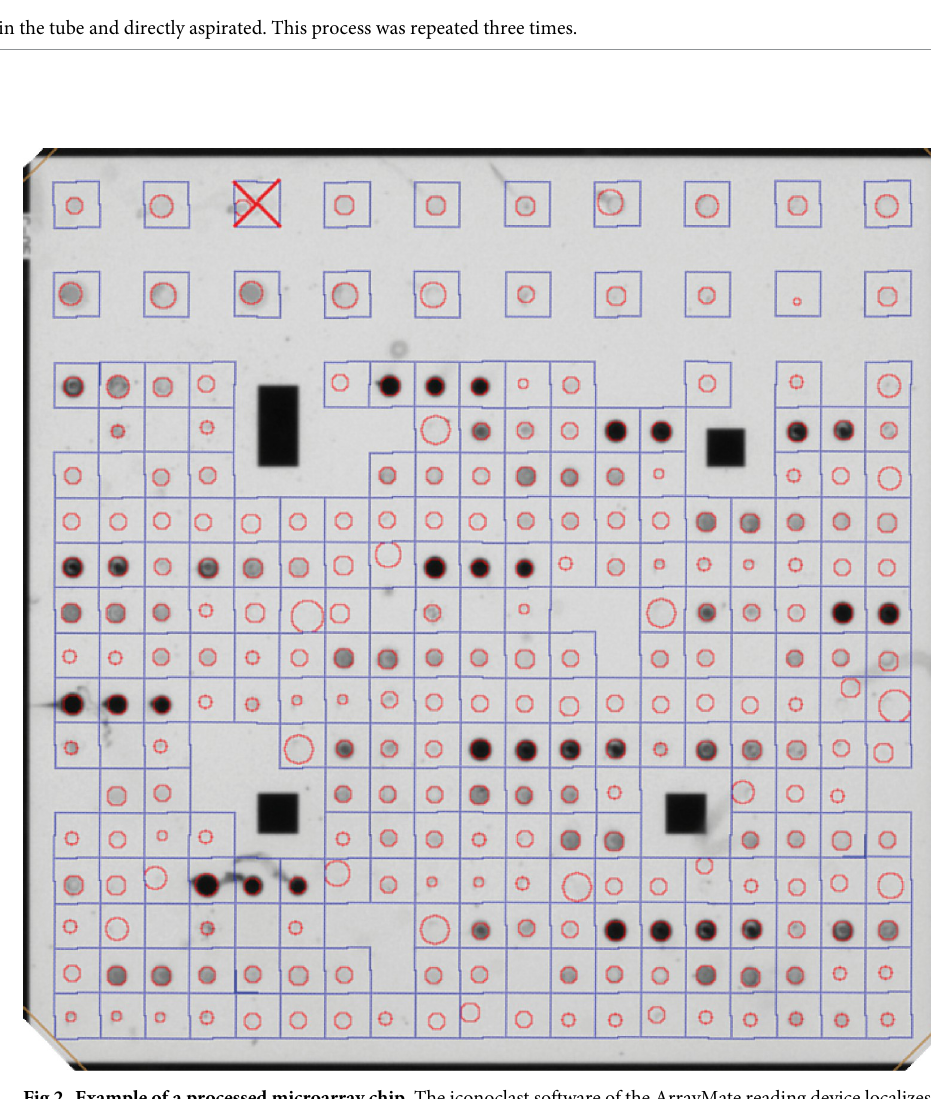
Fig 2. Example of a processed microarray chip. The iconoclast software of the ArrayMate reading device localizes the different antigen spots. The spot area is marked with a red circle. The signal intensity of every spot is calculated from 30% of the darkest pixels within the red circle. Red crosses represent invalid measurements. The original size of the chip is 4.36 mm x 4.36